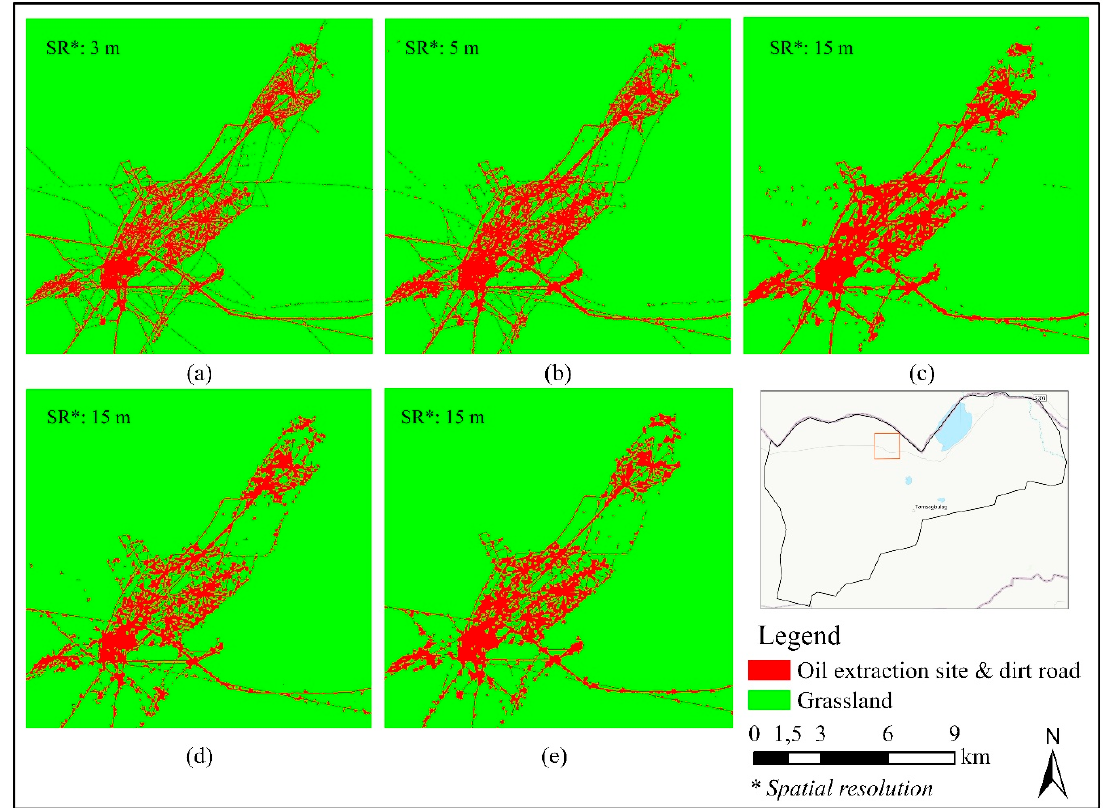
Figure 4. Comparison maps of the classification result: ( a ) PlanetScope imagery 3 m, ( b ) RapidEye imagery 5 m, ( c ) Landsat ETM + imagery 15 m, ( d ) PlanetScope spatially binned imagery 15 m, ( e ) RapidEye spatially binned imagery 15 m. The location of the comparison area is shown in the lower right map.